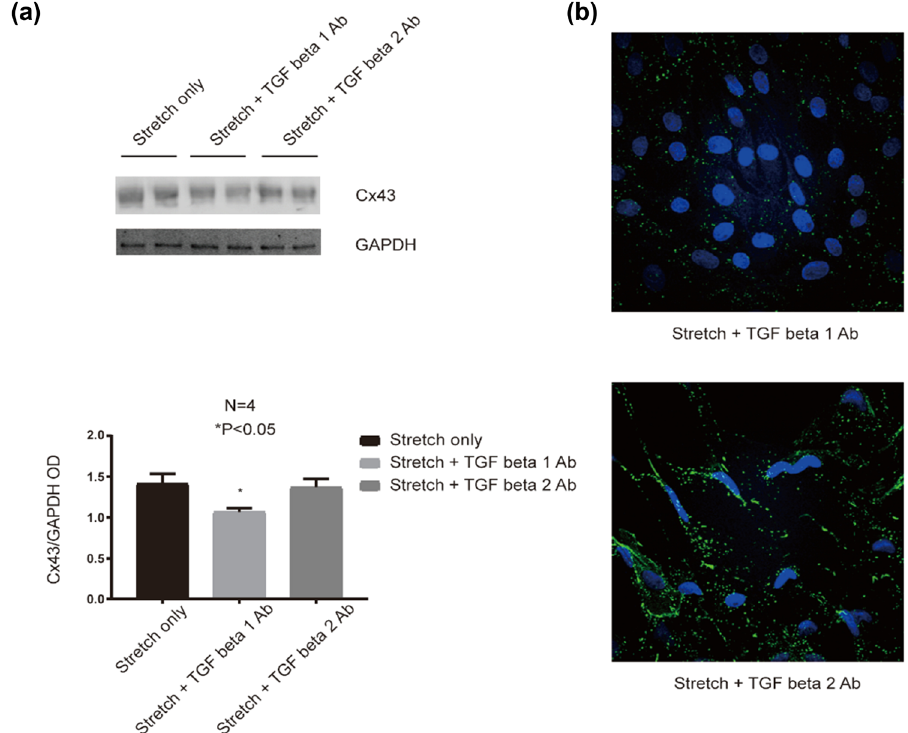
Figure 6: Administration of TGF beta1 neutralizing antibody ( Ab ) blocks the increment of Cx43 expression in HUVECs with stretch. ( a ) The relative protein level of Cx43 in HUVECs with stretch or/and TGF beta1 Ab/TGF beta2 Ab by western blotting. * P < 0.05 vs the stretch only. (